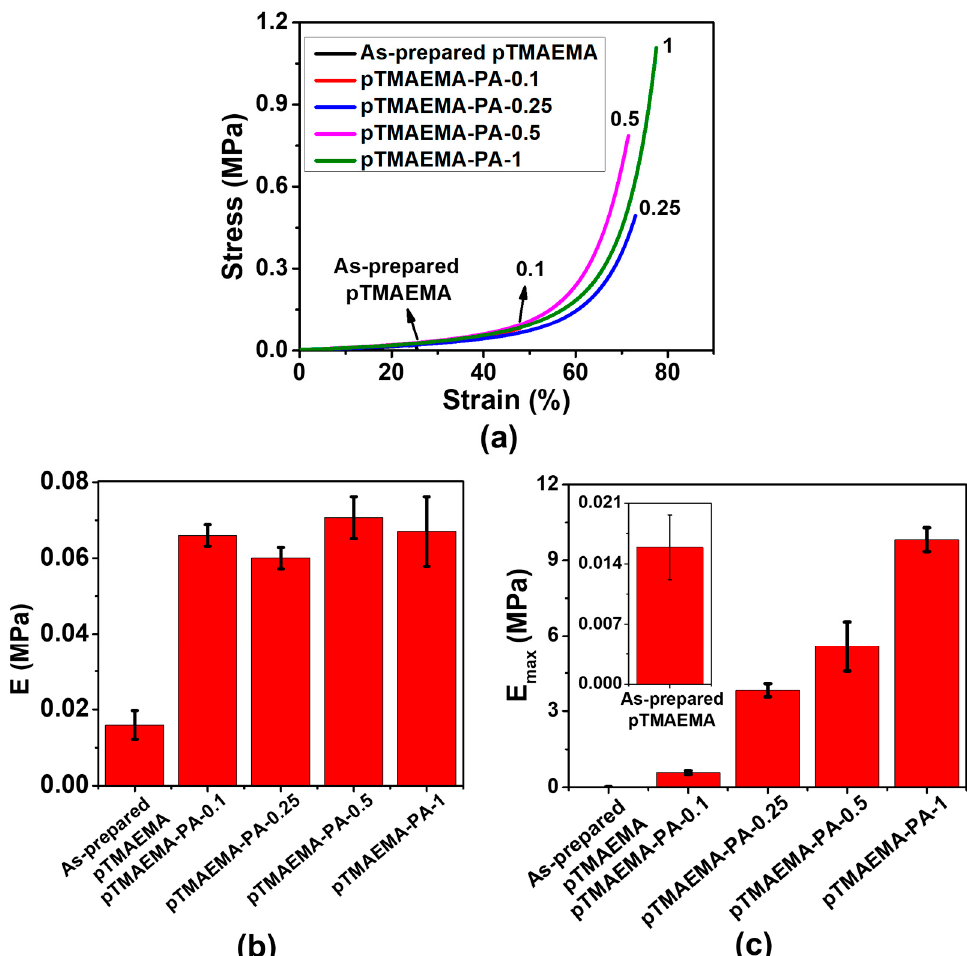
Figure 1. Concentration-dependent properties of poly((trimethylamino)ethyl methacrylate chloride)- phytic acid hydrogel (pTMAEMA-PA): ( a ) Compressive stress-strain curves of pTMAEMA-PA, ( b ) Young ′ s modulus ( E ) and ( c ) maximum compressive modulus (5% strain before fracture) ( E max ).